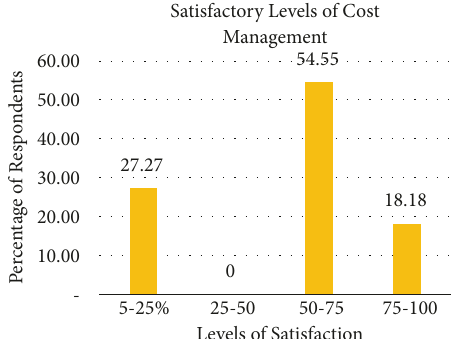
Figure 1: Details of respondents who were satisfied with cost management practices and